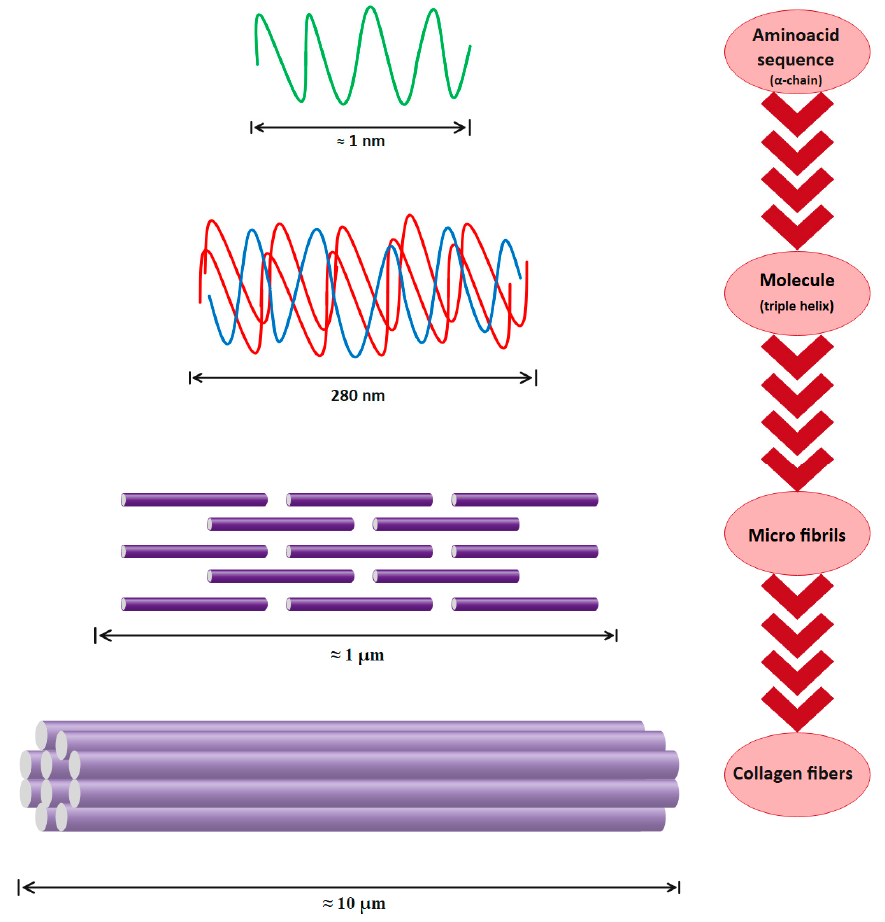
Figure 4. Type I collagen hierarchical organization.